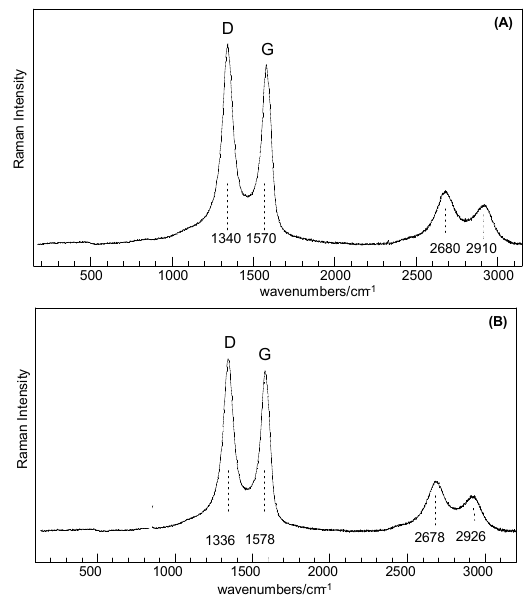
Figure 3. Full scan Raman spectra: ( A ) SiO 2 –C sample; ( B ) SiO 2 –C sample treated 24 h at 250 ◦ C in liquid